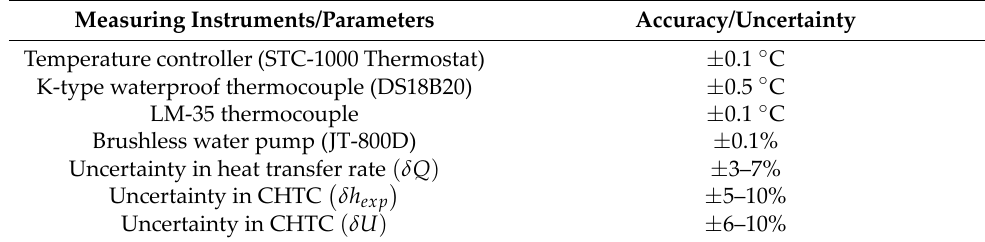
Table 4. Uncertainly in the measurement instruments and parameters.